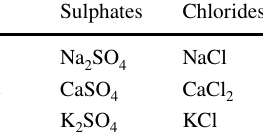
Table 4 Salts used in the preparation of the brines